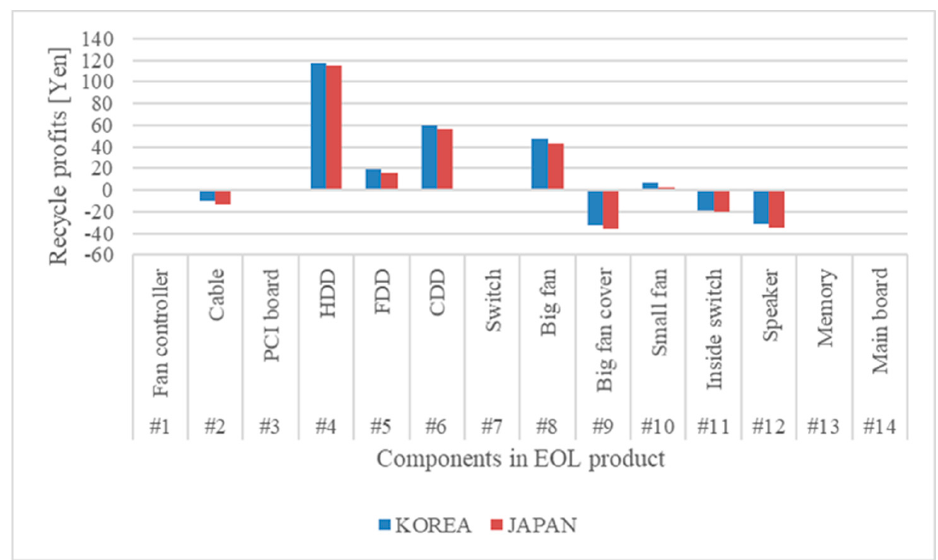
Figure 5. Comparison of reselling profits for each component in Korea and Japan.